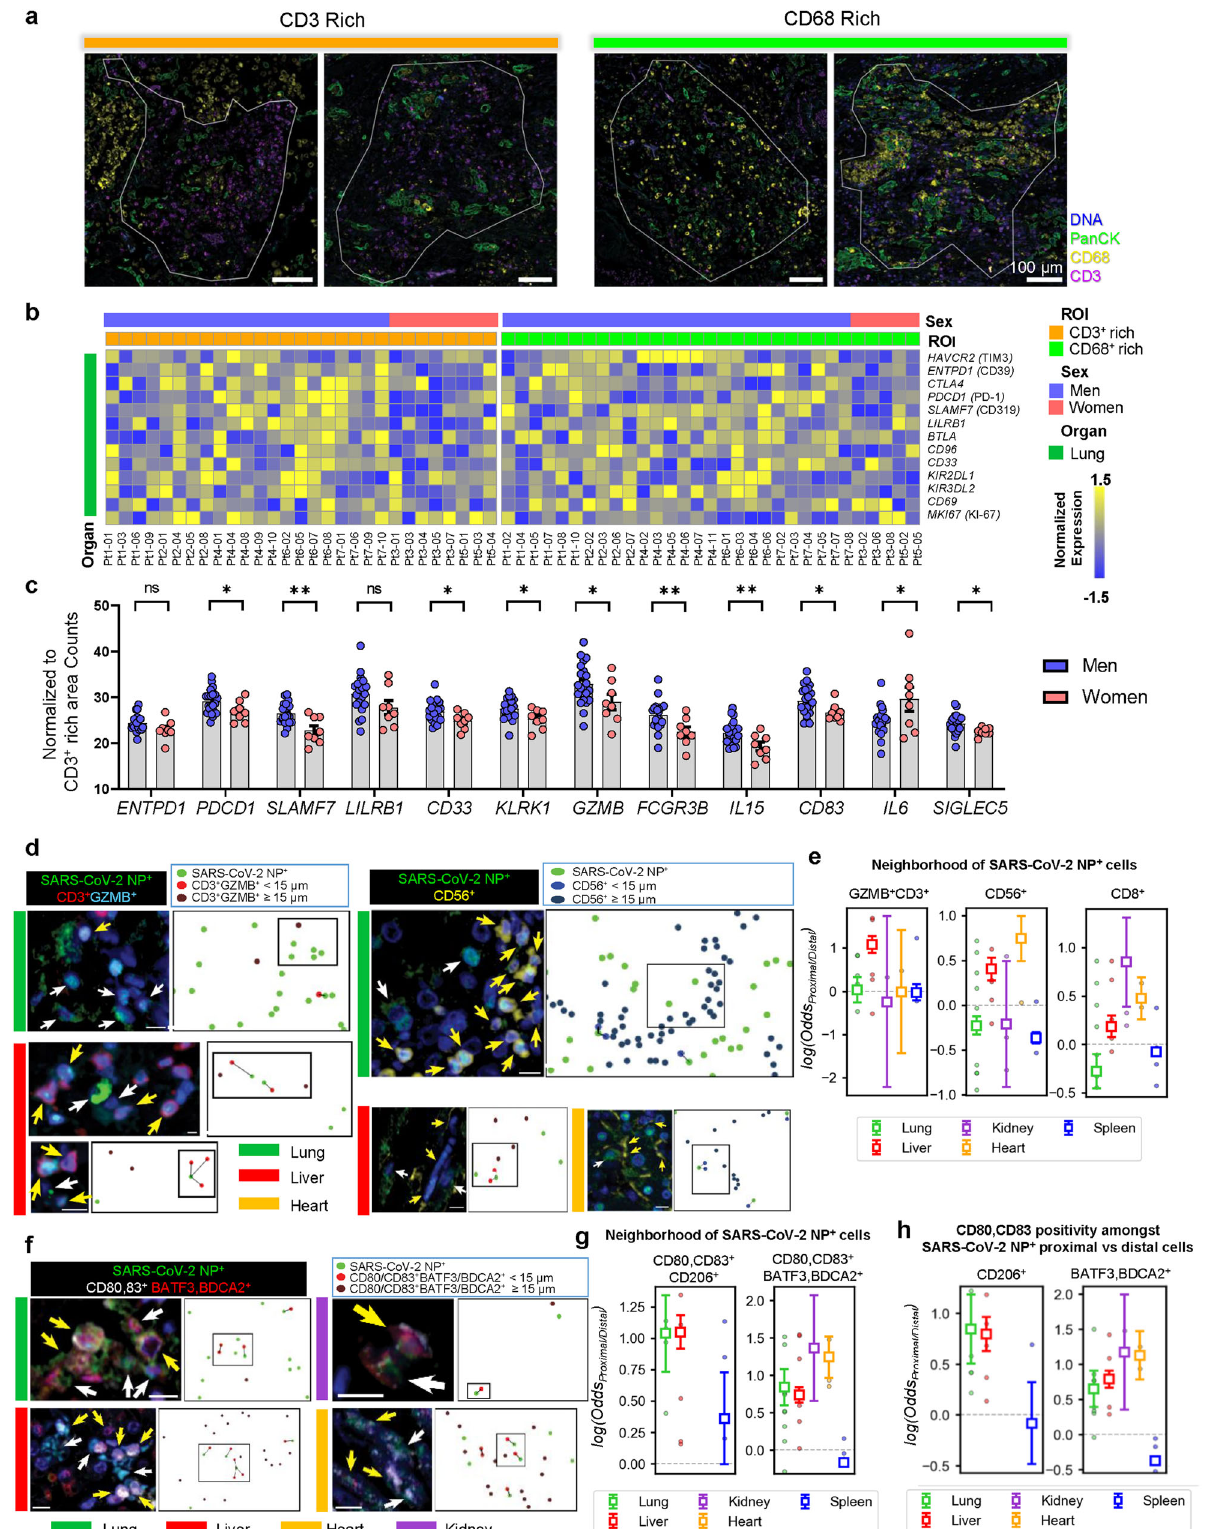
and macrophages proximal to viral antigens have a higher ten- dency to be activated than distal DCs and macrophages. Ulti- mately, MAS corresponds to our model whereby such differential contributions originate from the greater proximity of myeloid cells than lymphocytes to infected cells.